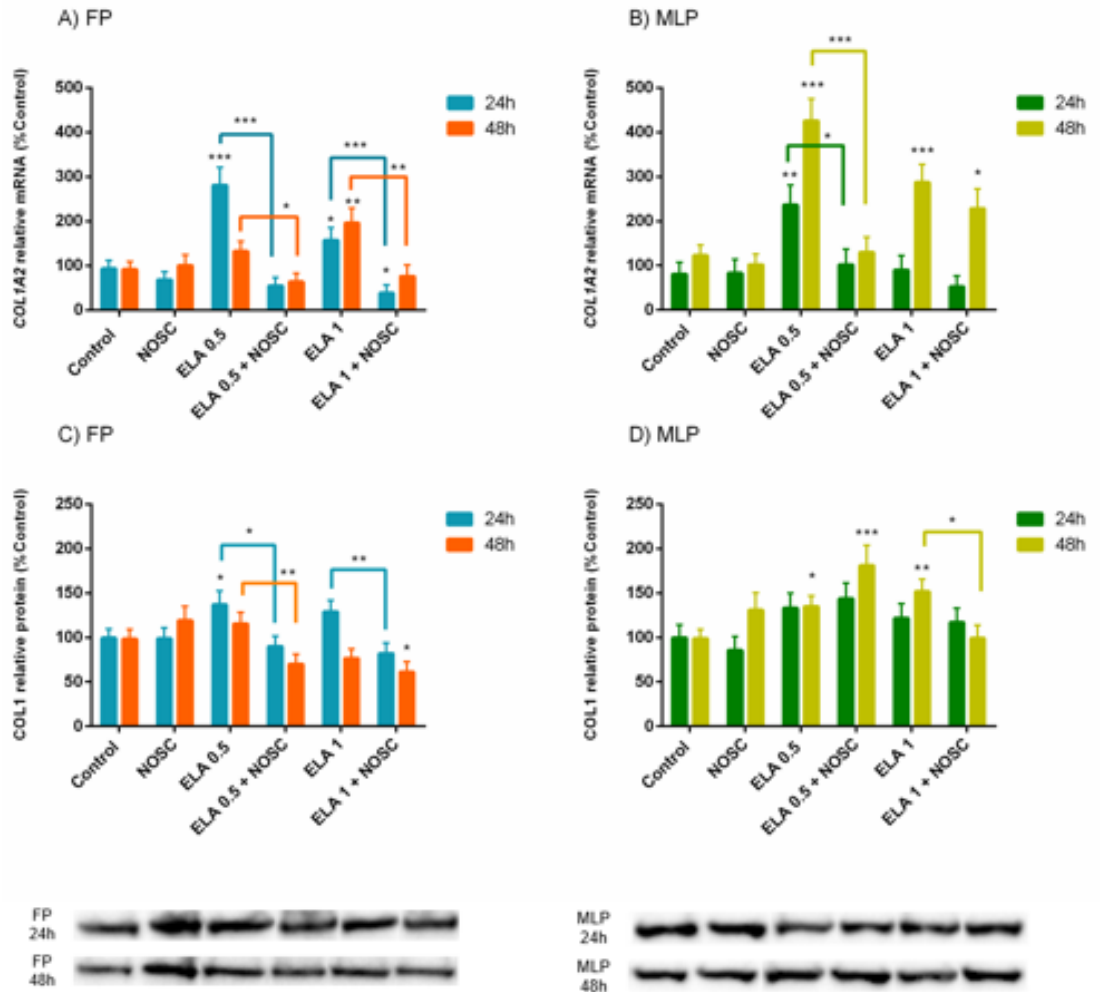
Figure 2. Effect of elastase (ELA; 0.5 or 1 µ g/mL), noscapine (NOSC; 45 µ g/mL), or ELA (0.5 or 1 µ g/mL) + NOSC (45 µ g/mL) treatments during 24 or 48 h in explants of mare endometrium from follicular phase (FP) or mid-luteal phase (MLP) on relative collagen type I alpha 2 chain ( COL1A2 ) mRNA transcription ( A , B ) and collagen type I (COL1) protein relative abundance ( C , D ). Results were considered significant at p < 0.05 and shown as least square mean ± SEM. Asterisks alone represent significant differences relative to the respective control and asterisks above connecting lines indicate significant differences of ELA + NOSC treatment relative to the respective ELA-treated group (* p < 0.05; ** p < 0.01; *** p < 0.001).